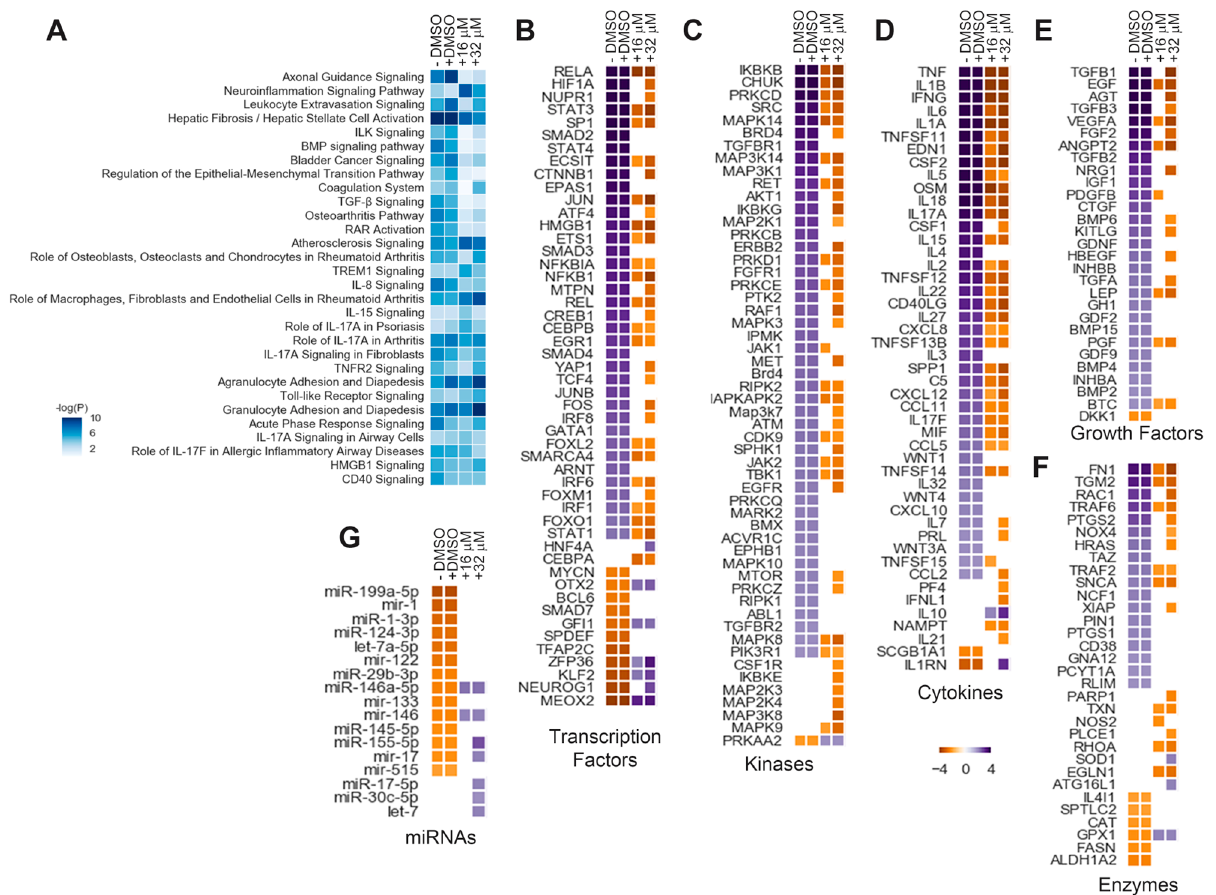
Figure 3. BAY651942 regulated transcriptome dynamics of TGF– β /TNF– α -induced RPE. ( A ) Top canonical pathways were predicted based on the alteration of highly-enriched genes that changed in abundance (activated or inhibited) from DMSO and BAY651942 treated hiPS-RPE monolayers prior to TGF– β /TNF– α -induced EMT ( B – G ) heatmaps of IPA-generated upstream regulator analysis from DMSO- and BAY651942-treated hiPS RPE monolayers. IPA uses activation Z-score as a statistical measure of the match between expected relationship direction and observed changes in the gene expression regulator such as different transcription factors; (TFs) ( B ), kinases ( C ), cytokines ( D ), growth factors ( E ), enzymes ( F ), and miRNAs ( G ) were predicted to be activated (violet) or inhibited (yellow) after DMSO and BAY651942. Z-scores of >2 (activated) or < − 2 (inhibited) were considered significant. Only genes with statistically significant changes at an FDR of 5% ( p < 0.05) were included in the analysis.